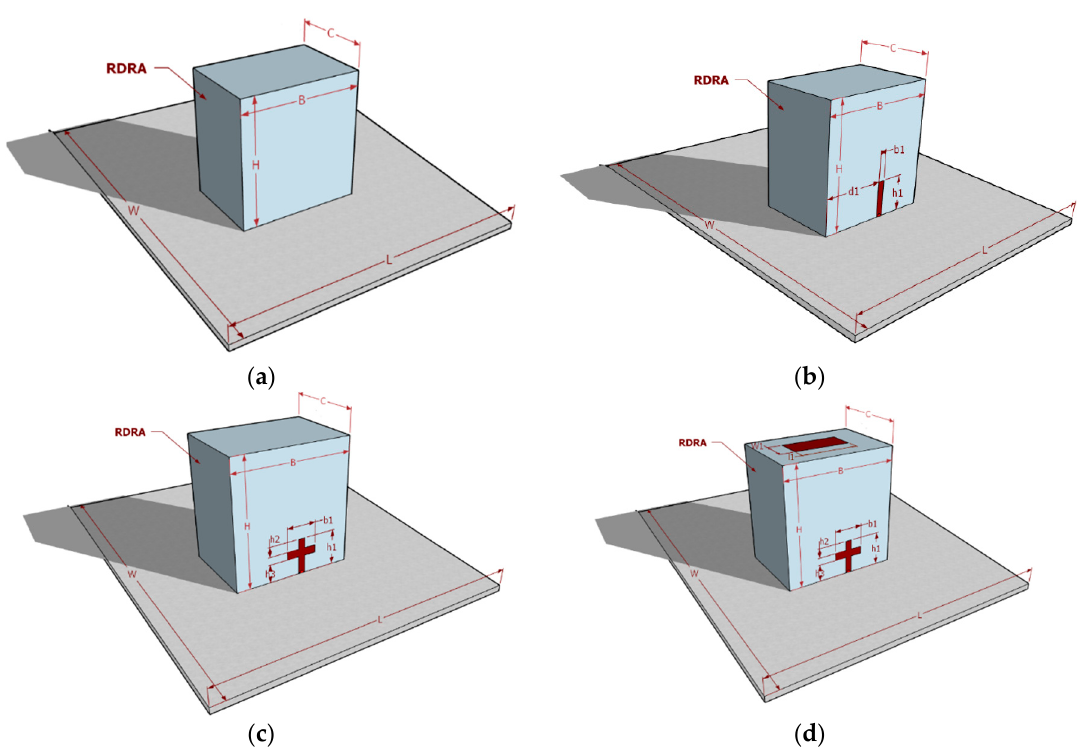
Figure 2. Evolution of the RDRA (3-D View) ( a ) Simple RDRA, ( b ) Linear polarized DRA, ( c ) circularly polarized RDRA, ( d ) desired RDRA.